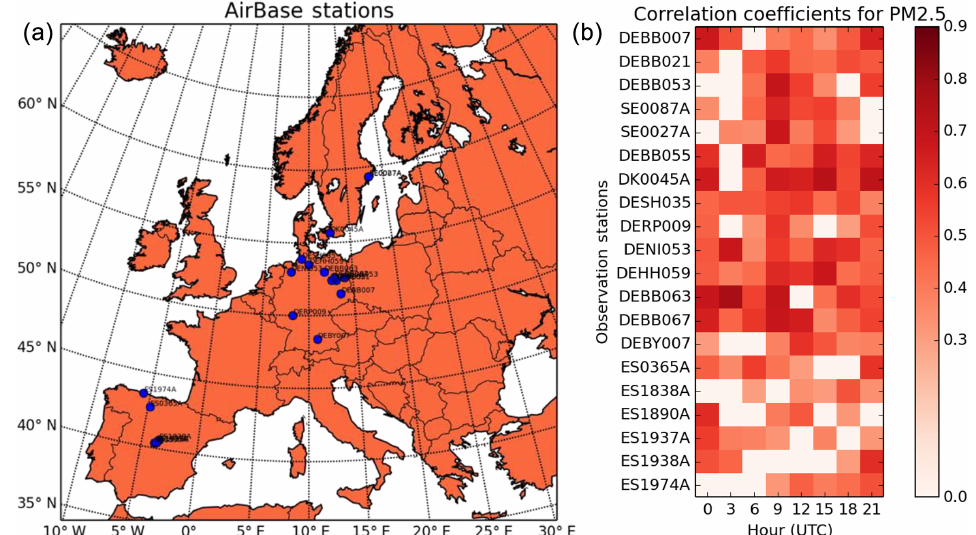
Figure 14. (a) Map of selected AirBase air quality monitoring stations (http://acm.eionet.europa.eu/databases/airbase/) across Europe; (b) PM 2 . 5 correlation coefficients on a diurnal cycle for selected AirBase observation stations.